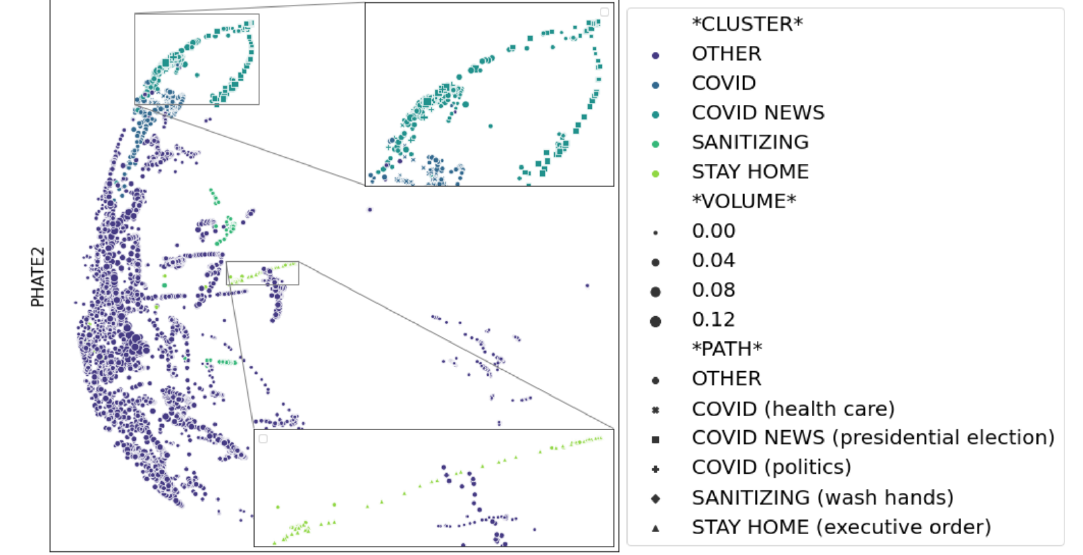
Figure 4. Potential of heat-diffusion for affinity-based transition embedding (PHATE) for all word distributions. Here the two bounding boxes and insets highlight two of the COVID-19-related topic clusters/paths (COVID/COVID NEWS and STAY HOME). The colors, sizes, and styles signify various clusters, tweet volumes, and